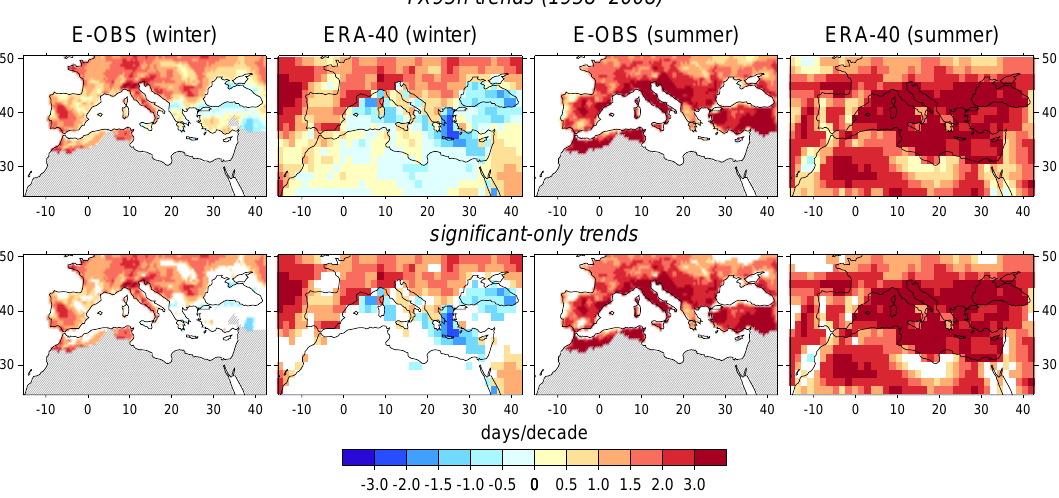
Fig. 4. Trends of winter (left-hand columns) and summer (right-hand columns) TX95n (days per decade), over the period 1958–2008, from E-OBS and ERA-40 data. The lower panel shows only statistically-significant